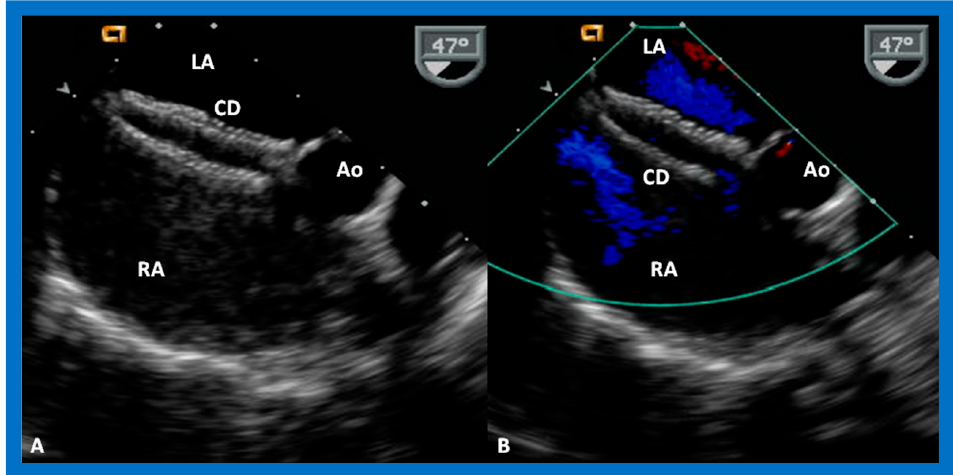
Figure 33. Transesophageal echocardiographic images after the implantation of an Amplatzer Crib- riform Device (CD) illustrating the location of right (RA) and left (LA) atrial discs across the atrial septal defect (ASD) ( A ). On color Doppler imaging ( B ), there is no residual shunt ( B ) in a child who had a fenestrated ASD demonstrated in Figures 31 and 32. Ao, aorta; LA, left atrium; RA, right atrium. Reproduced from Reference [6].